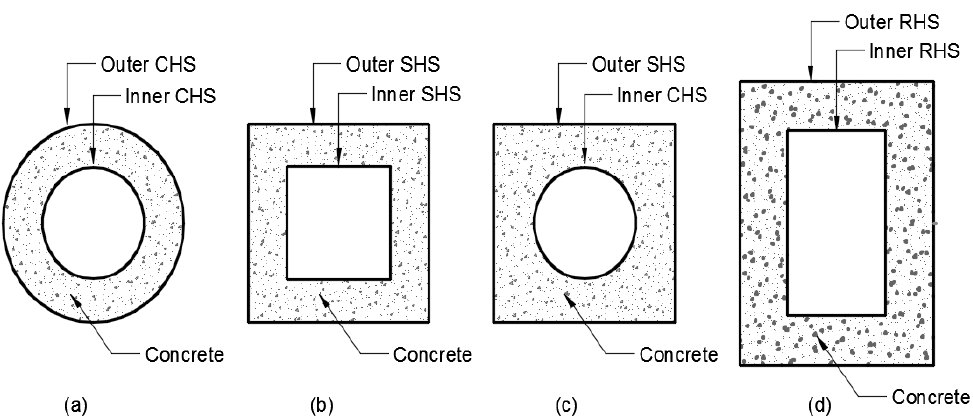
Figure 1. Cross-sections of double skin steel tube [20] ( a ) Circular hollow section (CHS) inner and outer, ( b ) Squre hollow section (SHS) inner and outer, ( c ) Circular hollow section (CHS) inner and squre hollow section (SHS) outer), and ( d ) Rectangular hollow sections (RHS) inner and outer.